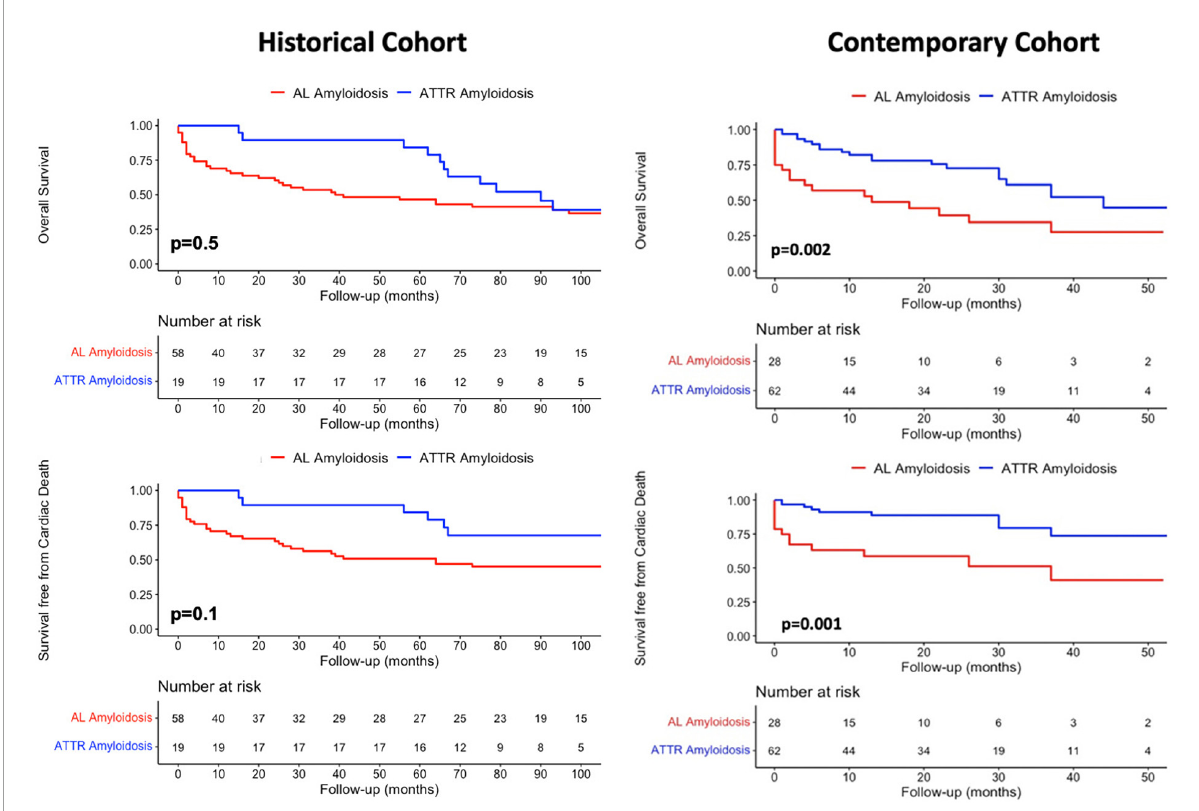
FIGURE4 Kaplan-Meier survival analysis for (Top row) overall mortality and competing risk analysis for (Bottom row) cardiac death according to amyloidosis etiology in the historical and contemporary cohorts. AL, Light Chain Amyloidosis; ATTR, Transthyretin